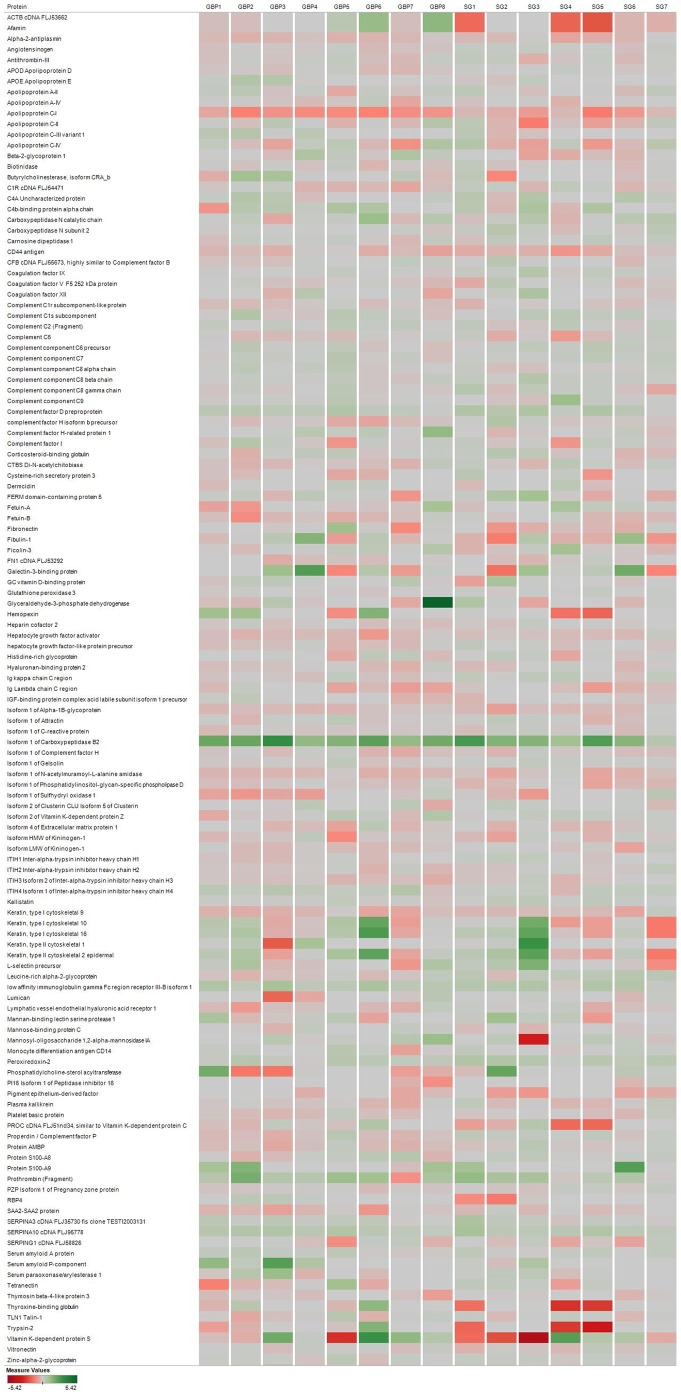
Heat map showing patient specific changes of all detected proteins.Each protein is represented on an individual row with data from each patient stacked in columns (GBP1 to GBP8 for GBP, SG1-SG7 for SG). Intensity of color corresponds to the degree of change from red (decrease) to green (increase) after surgery.